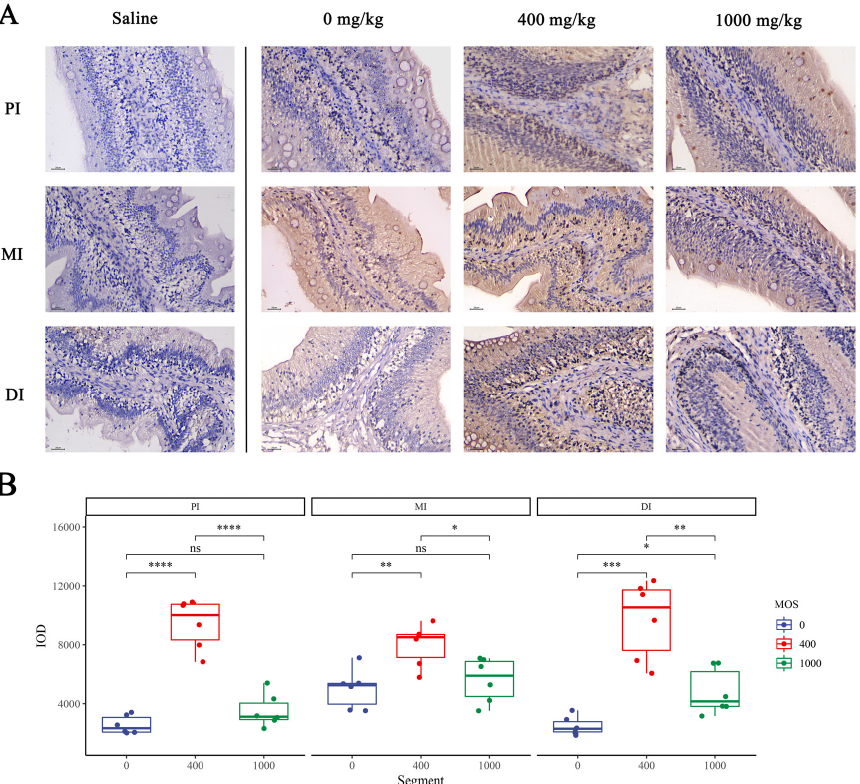
Figure 3. The effect of MOS on ZO-1 expression by the immunohistochemistry method in three intestinal segments after infection with Aeromonas hydrophila. ( A ) ZO-1 protein expression of intestine in the 0 mg/kg MOS, 400 mg/kg MOS and 1000 mg/kg MOS groups; ( B ) Quantification of the positive area as revealed by Image Pro Plus 6.0. N = 6 for each MOS level. Differences among the variables were assessed using Student’s t -tests. Statistical significance: * p < 0.05; ** p < 0.01, *** p < 0.001; **** p < 0.0001; ns: not